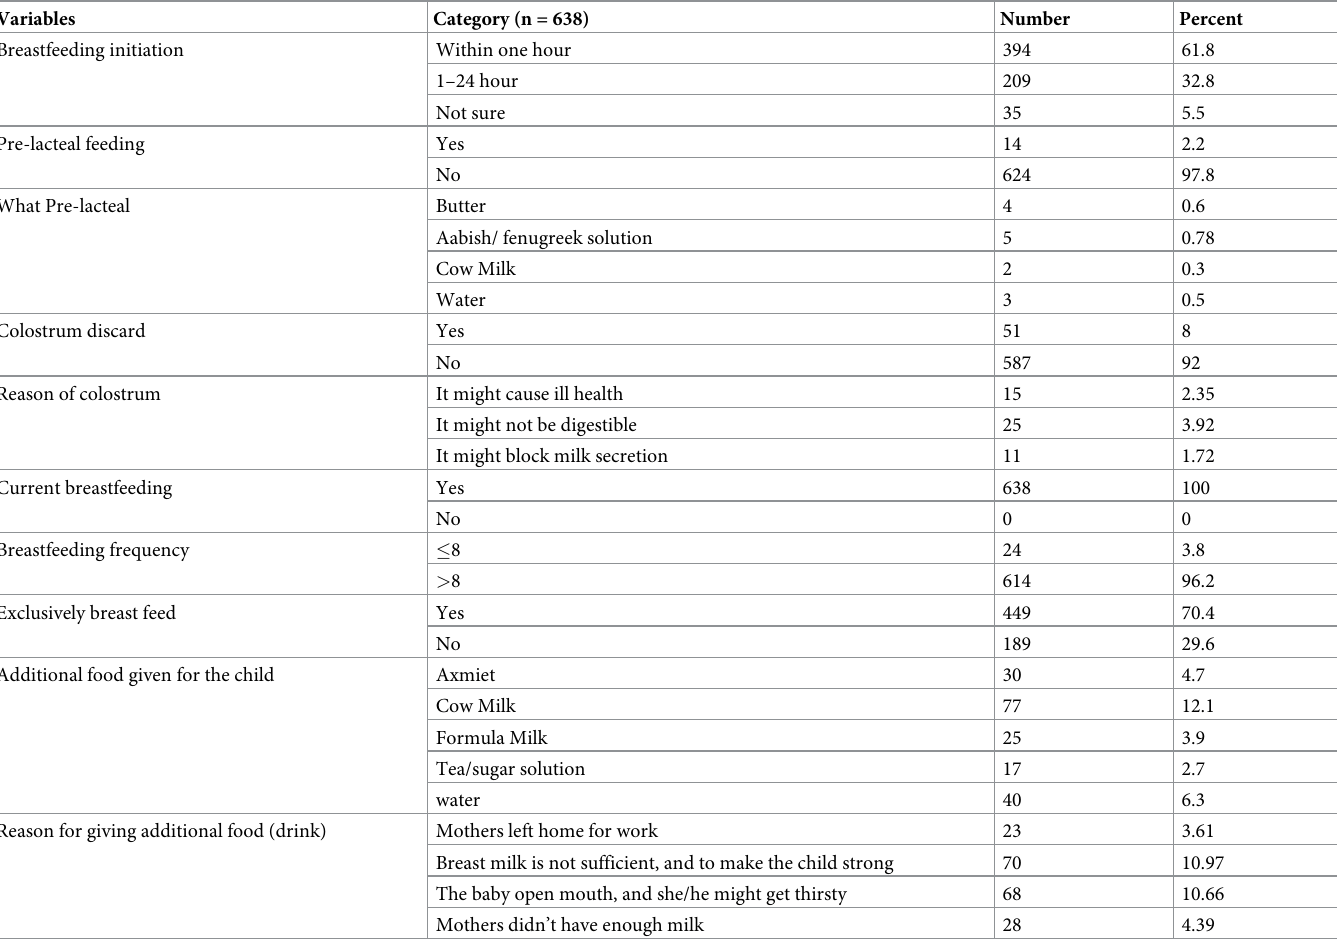
Table 3. Distribution of mothers by their exclusive breastfeeding experiences (n =